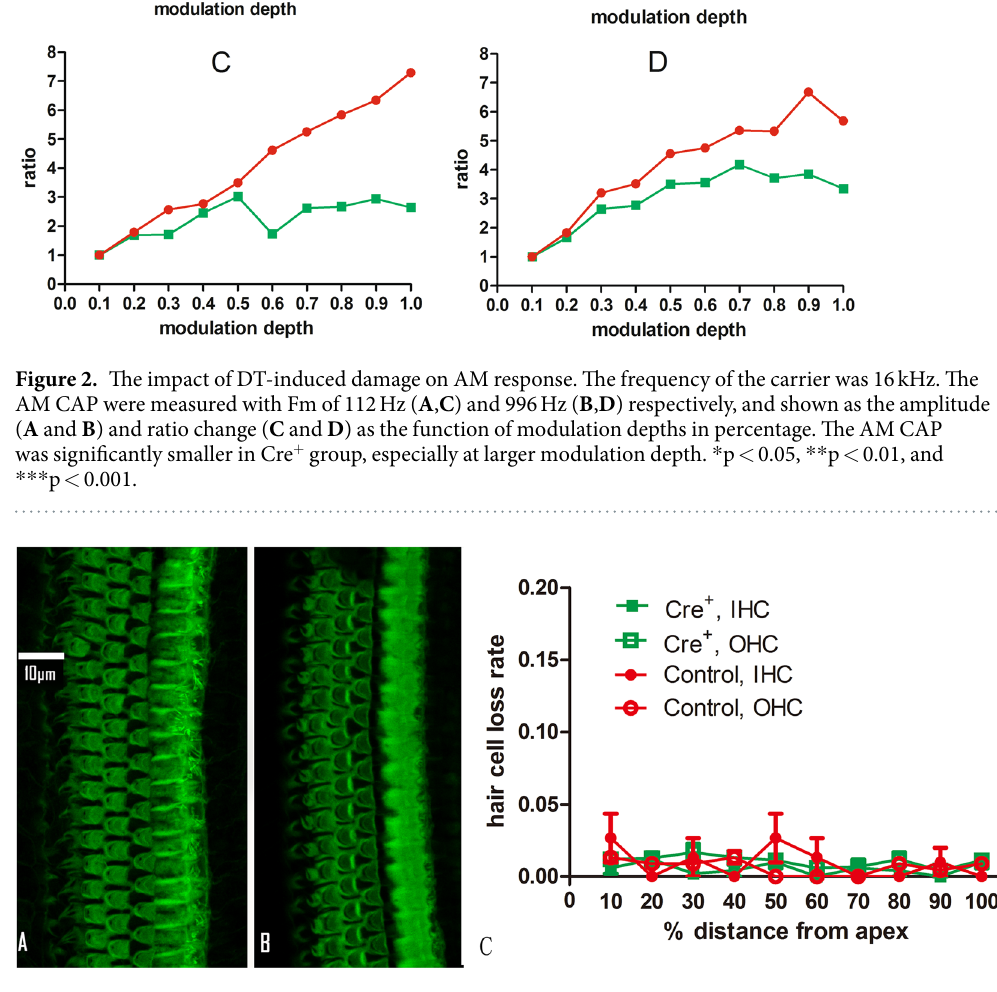
Figure 3. The DT impact on HCs. ( A and B ) Representative images of HCs in the surface preparation of the basilar membrane from the control and the Cre + group respectively. HCs are stained green with antibody against actin. ( C ) The averaged cochleograms of both groups showing percentage HC loss as a function of percentage distance from the